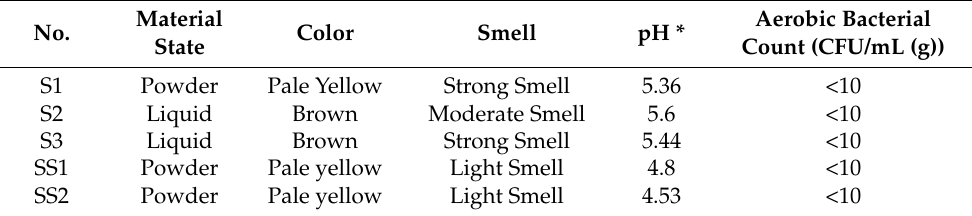
Table 1. The primary characteristics of the five sericin